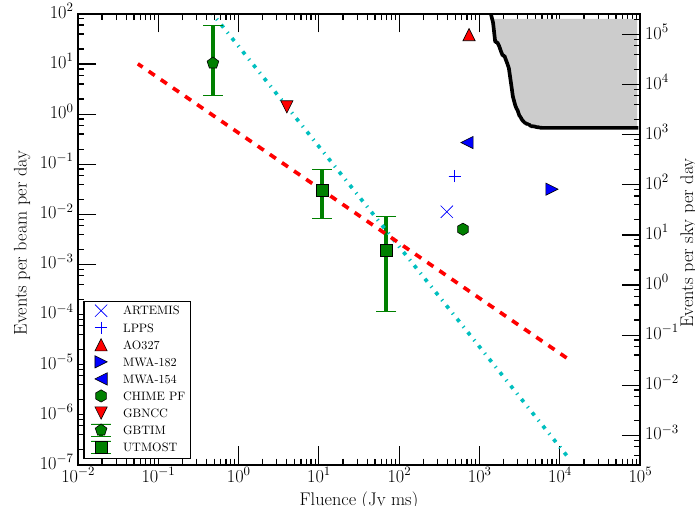
Figure 5. Figure 7 from [114] “The FRATS project: real-time searches for fast radio bursts and other fast transients with LOFAR at 135 MHz”, Credit: S. ter Veen, A&A, vol 621, page 57, 2019, reproduced with permission © ESO. reproduced with permission from. It summarises the limits on FRB event rates ( R FRB ) versus fluence, normalised to a pulse width of 8ms. They were obtained at different low frequencies from either the detections (symbols with error bars) or non-detections (other symbols), described in these sections in the era before CHIME. The color coding represents different frequency bands: green for ∼ 800MHz; red for ∼ 350MHz; blue for < 200MHz plus the limits obtained by the FRATS survey given by the shaded grey region. The red dashed line represents γ = − 1 for the FRB distribution, while the green dotted line represents a Euclidean distribution with γ = −